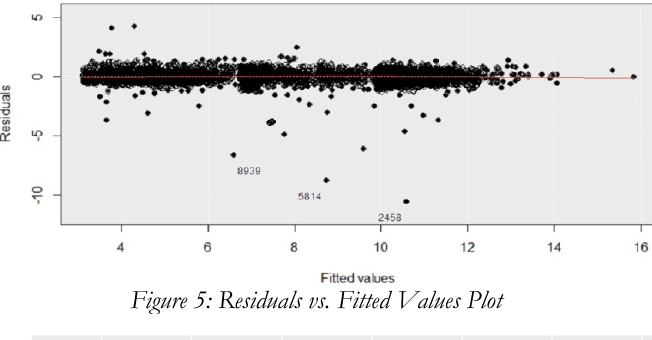
Figure 5: Residuals vs. Fitted Values Plot